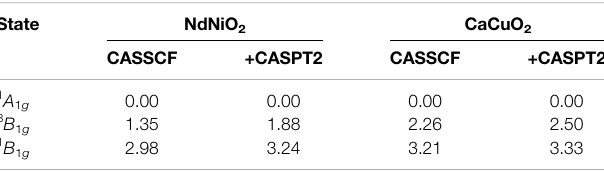
TABLE2| Relativeenergies(ineV)oftheelectronremoval d 8 statesinNdNiO 2 and the iso-structural CaCuO 2 obtained from CAS(12,14)SCF and CASSCF + CASPT2 calculations.